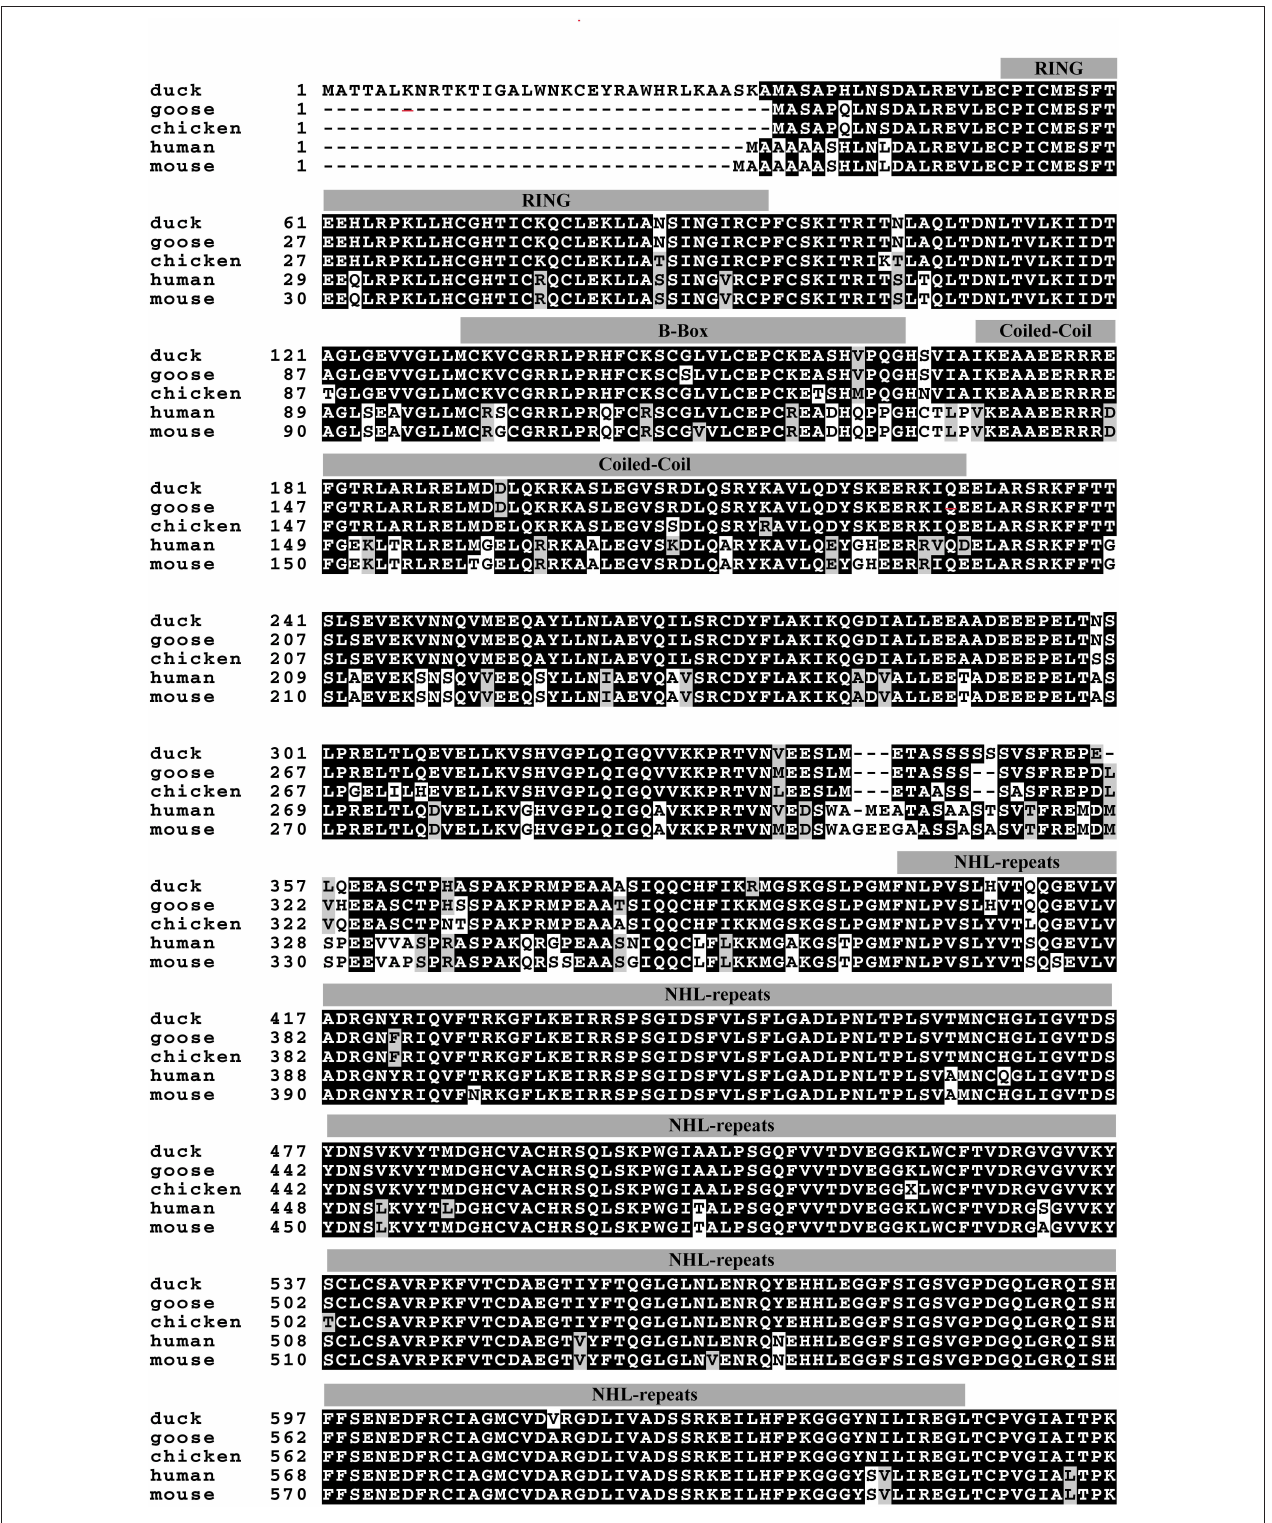
FIGURE 1 | Alignment of Peking duck TRIM32 amino acid sequence with goose, chicken, human, and mouse TRIM32. The sequences of TRIM32 are derived from GenBank. The accession numbers are goose (XP_013038246.1), chicken (XP_015135179.2), human (NP_036342.2), and mouse (NP_444314.2). The predicted motifs of duck TRIM32 (RING, a B box/coiled-coil domain and a NHL domain) were indicated on the sequences.